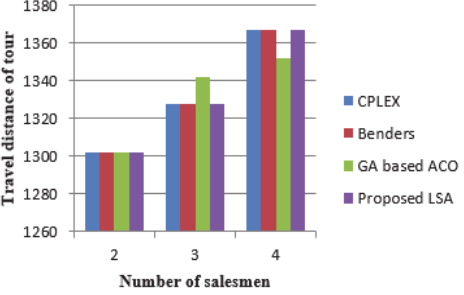
Fig. 4. Comparison of travel distance for br17 by considering two, three and four salesmen